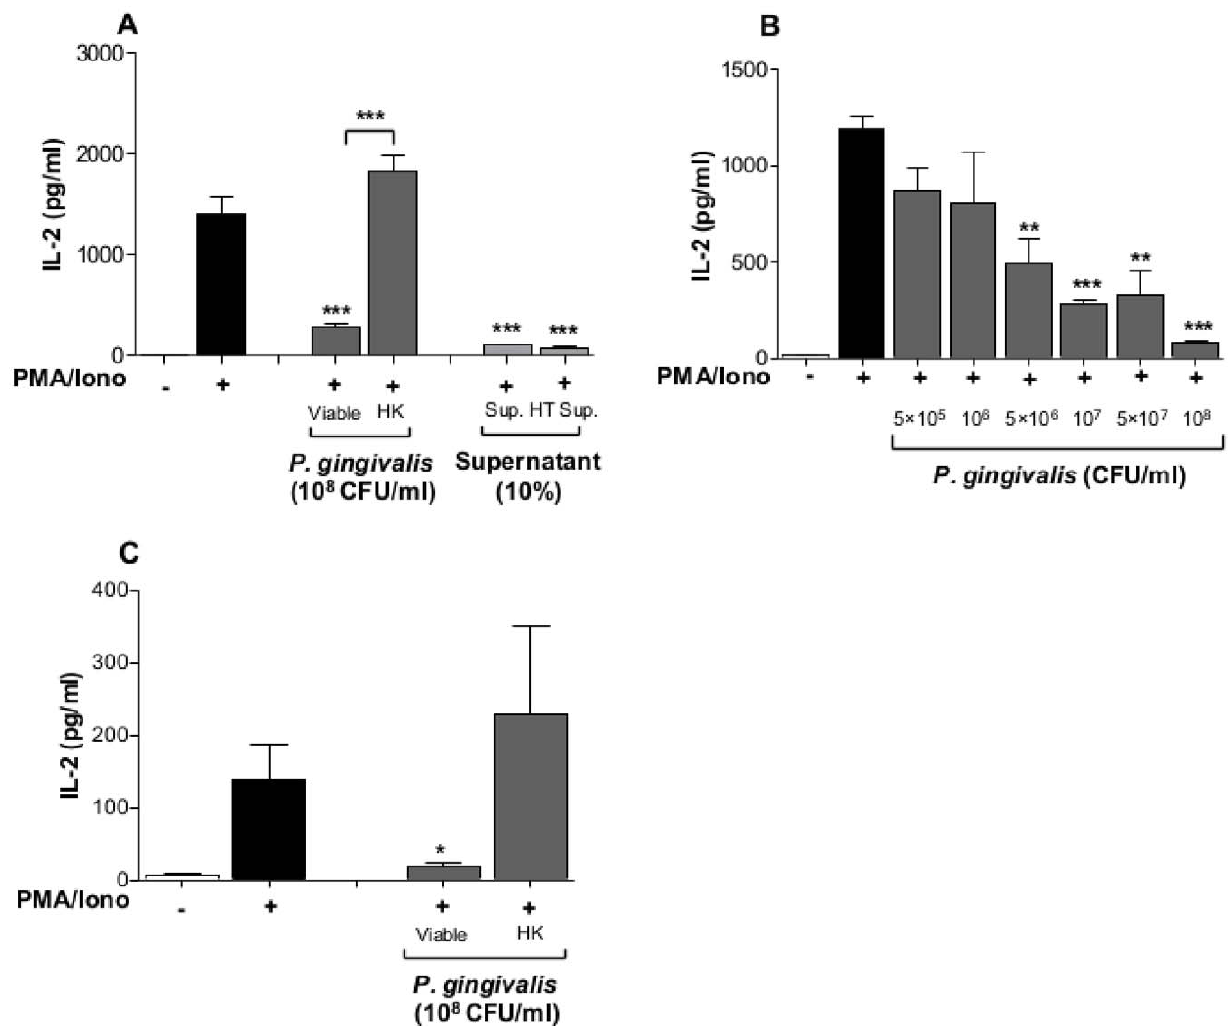
Figure 4. IL-2 accumulation decreases in response to viable P.gingivalis and its derived supernatant. A- Jurkat T-cells (10 6 cells/ml) were pre-treated with 10 8 CFU/ml of viable or heat-killed (HK) P. gingivalis (MOI:100) as well as 10% untreated- or heat-treated (HT) supernatant from P. gingivalis broth cultures for 1 h. The cells were then stimulated with 50 ng/ml PMA and 1 m g/ml Calcium ionophore for 24 h. IL-2 accumulation was significantly reduced by viable, but not heat-killed P. gingivalis in Jurkat T-cells, while both untreated and heat-treated bacterial supernatant resulted in a significant IL-2 reduction. B- T-cells were pre-treated with the indicated concentrations of viable P. gingivalis (MOI:0.5, 1, 5, 10, 50 and 100, respectively) for 1 h followed by stimulation with 50 ng/ml PMA and 1 m g/ml Calcium ionophore for 24 h. IL-2 accumulation was reduced in a dose- dependent manner. C- Primary cells were isolated as described in materials and methods. Cells were pre-treated with viable or heat-killed P. gingivalis for 1 h, followed by stimulation with 50 ng/ml PMA and 1 m g/ml Calcium ionophore for 24 h. Viable, but not heat-killed P. gingivalis (MOI:100) resulted in a significant reduction in IL-2 accumulation. *-p , 0.05; **-p , 0.01; ***-p , 0.001 (Statistical significance between different treatments and the positive control PMA/Iono, Student’s t